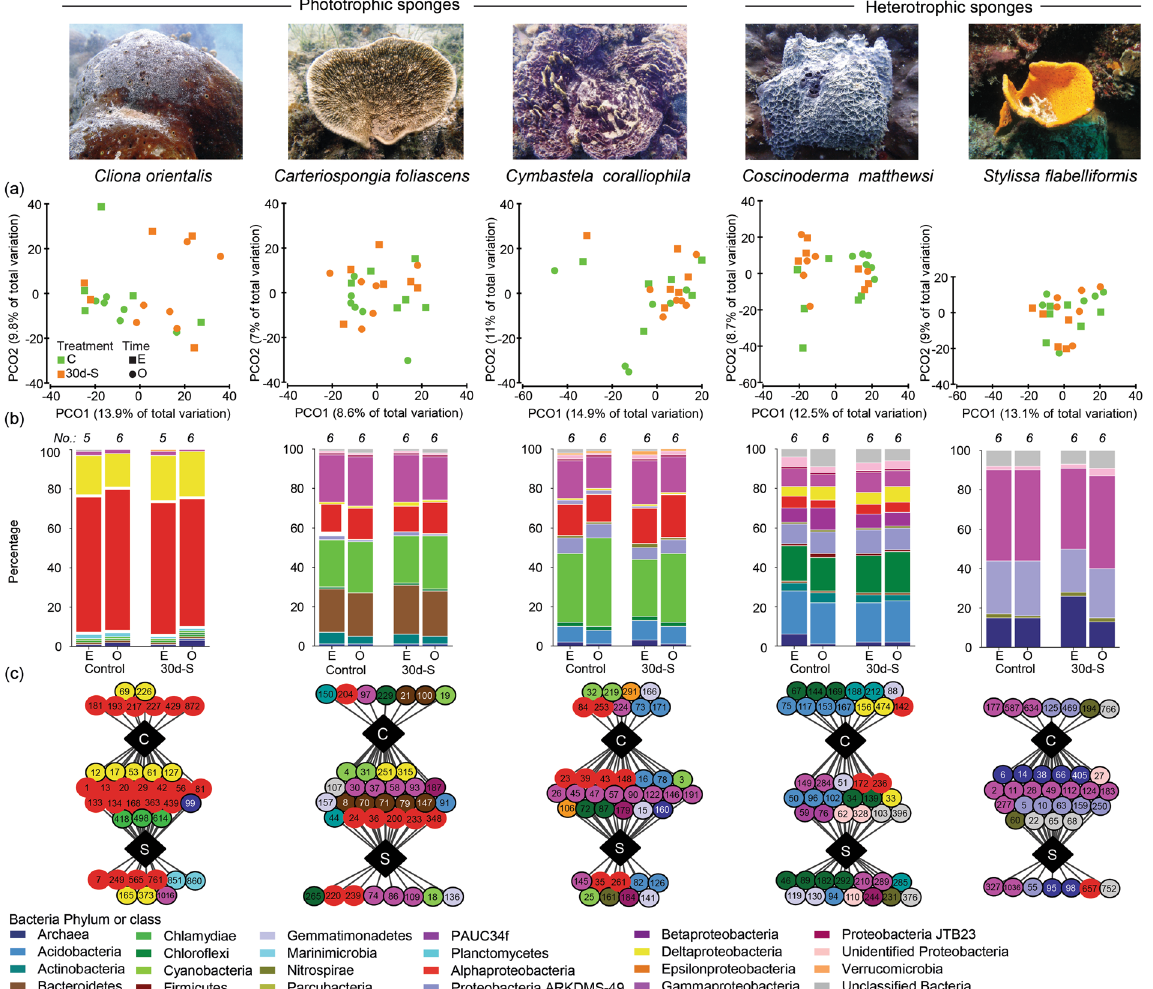
Figure 5. Microbial responses to smothering. ( a ) Principal coordinate analysis plots for control and samples smothered for 30 d (30d-S) at the end of the experimental period ( E ) and 14 d observational period ( O ), ( b ) Average relative abundance of each bacterial phylum (and class for Proteobacteria ) using OTUs representing greater than 1% of the community for 30d-S vs. control samples across both sampling times, ( c ) Cytoscape networks of the microbial community in all species for controls ( c ) versus 30d-S samples ( S ) across both sampling